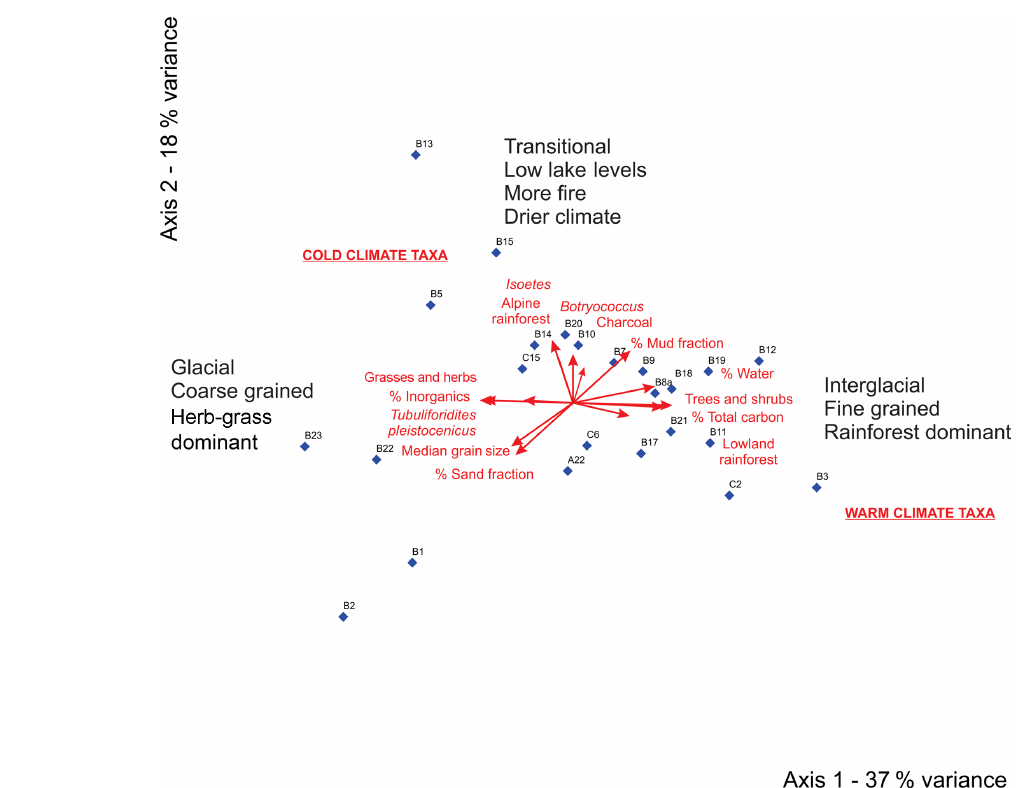
Figure 7. PCA bi-plot of core end data (pollen, LOI, and grain size). Correlations between data and axes >0 . 4 r 2 are shown as red arrows (indicating the direction of correlation). A preliminary interpretation of the environmental significance of the axes is